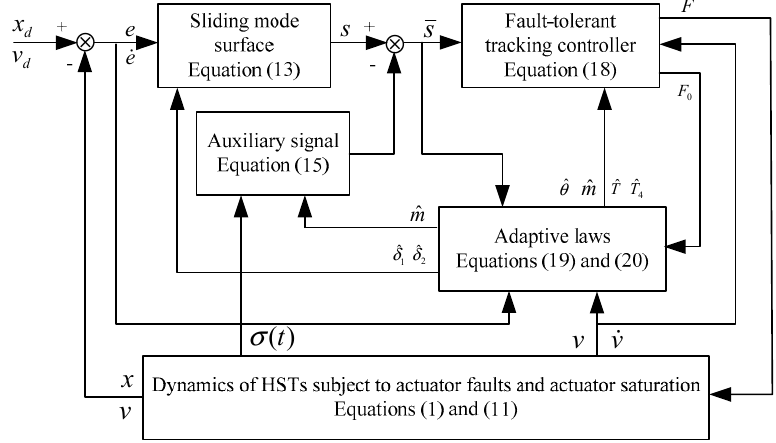
Figure 3. Block diagram of the proposed controller.